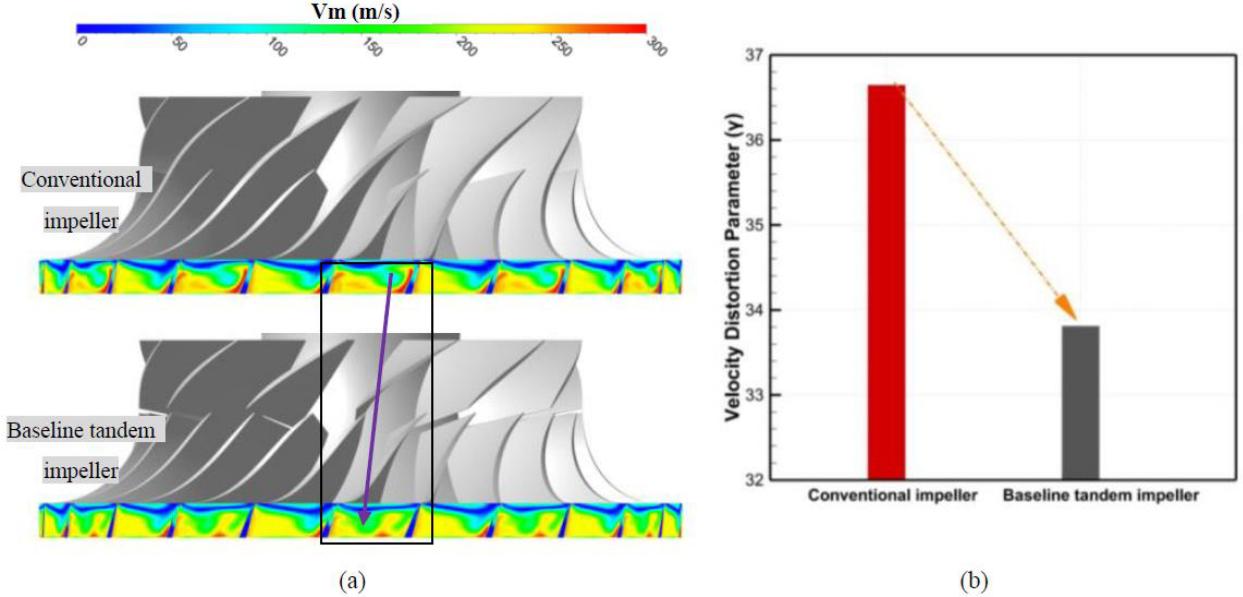
Figure 14. Comparison of the discharge flow uniformity for the conventional impeller and baseline tandem impeller ( P.E. point). ( a ) the distribution of meridional velocity Vm , and ( b ) the velocity distortion parameter γ.